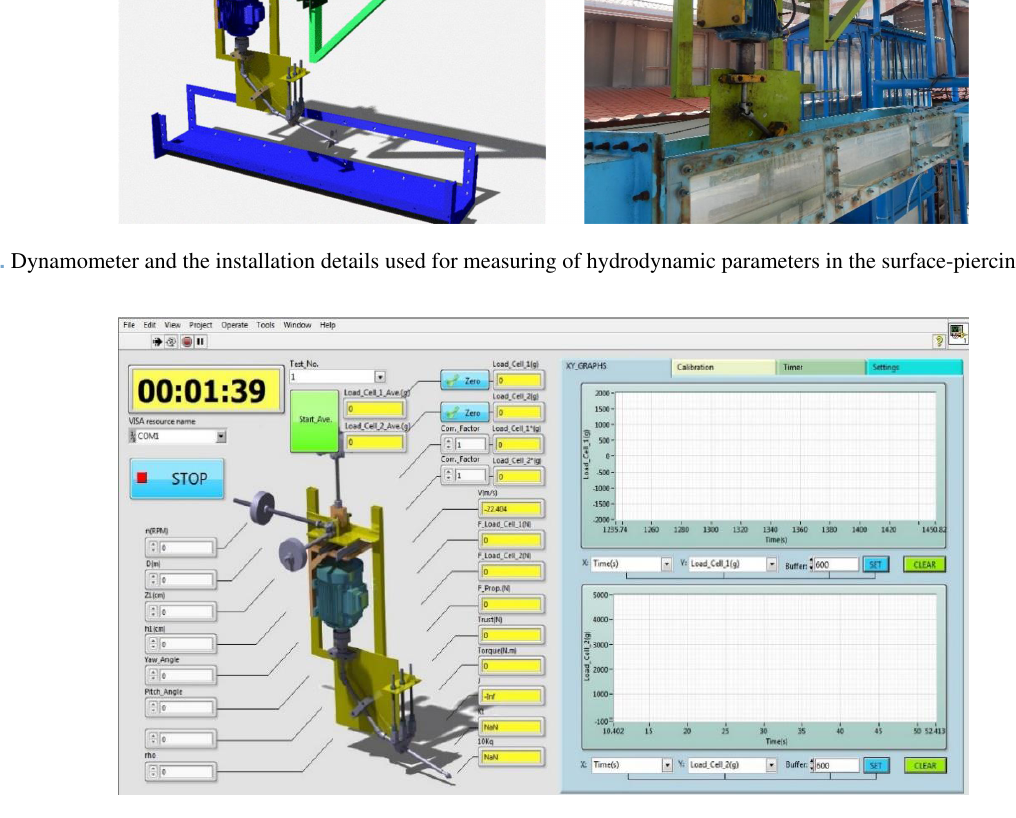
Figure 4. Parameters and the locations of the corresponding sensors in the experiment.